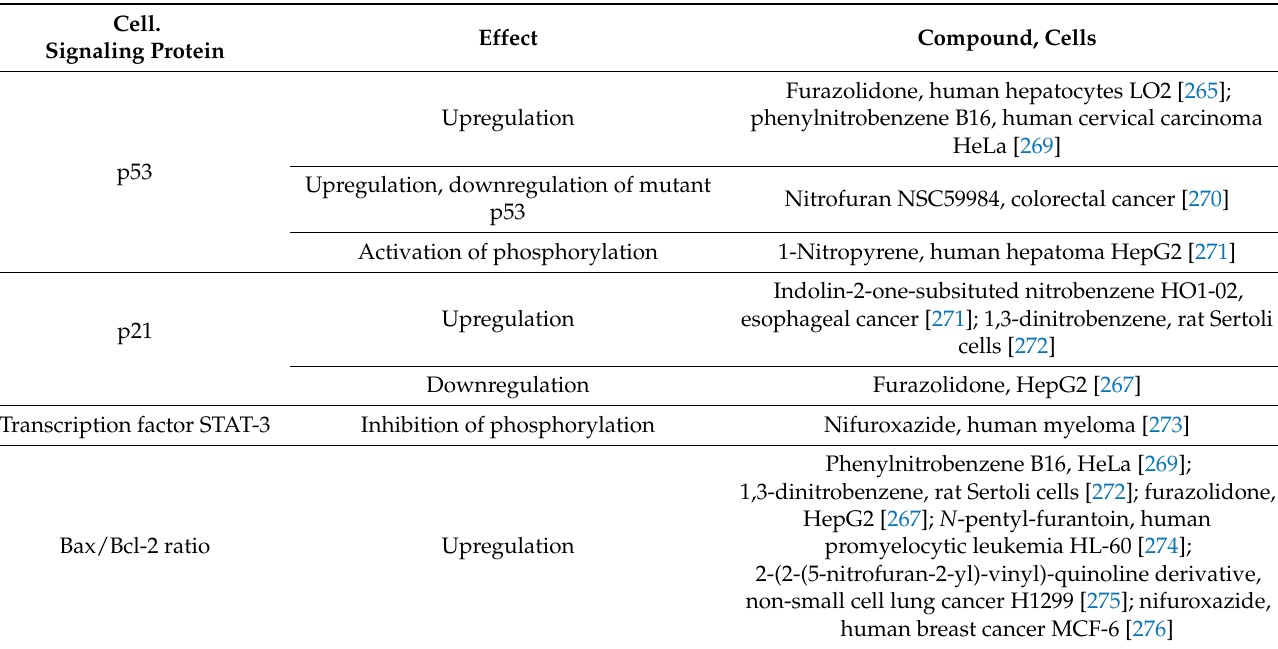
Table 5. Expression of cell signaling proteins during the apoptotic action of nitroaromatic compounds.